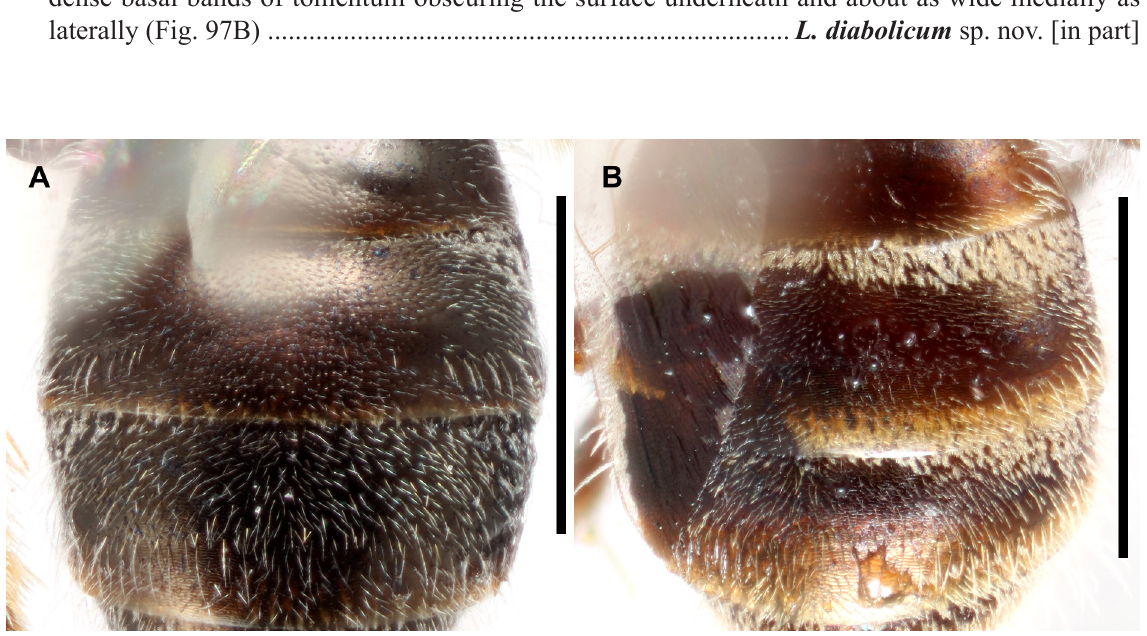
Fig. 97. T1–T3. A . Lasioglossum holzenthali sp. nov., ♀, with thin, sparse basal bands of tomentum and apical rims deeply and distinctly punctate. B . L. diabolicum sp. nov., ♀, with thick, dense basal bands of tomentum and apical rims impunctate. Scale bars = 1 mm.